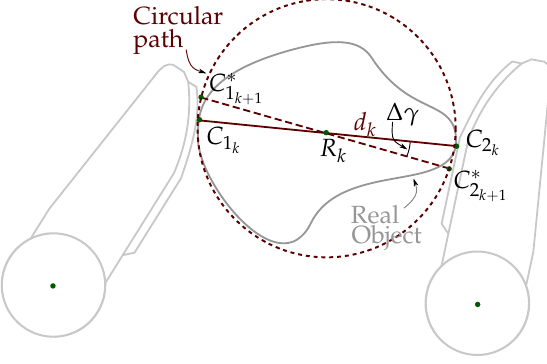
Figure 7. Movements used for the optimization of the object orientation. C 1 over a circular path with diameter d k centered at R k .